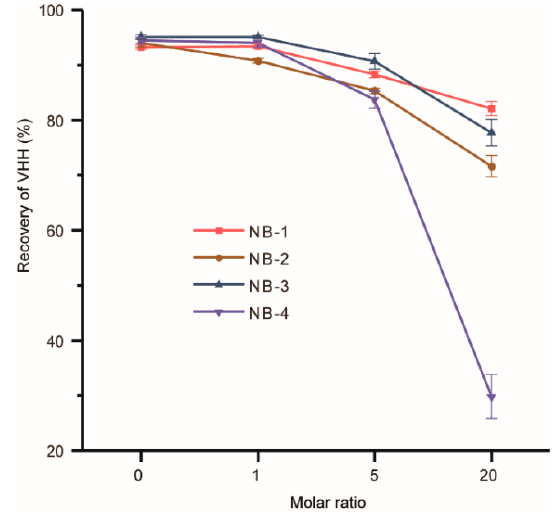
Figure 3. Recovery of the modified VHHs. Four different molar ratios of NHS-Fluo were added individually for modification. Each group had three repetitions, and the average was taking.